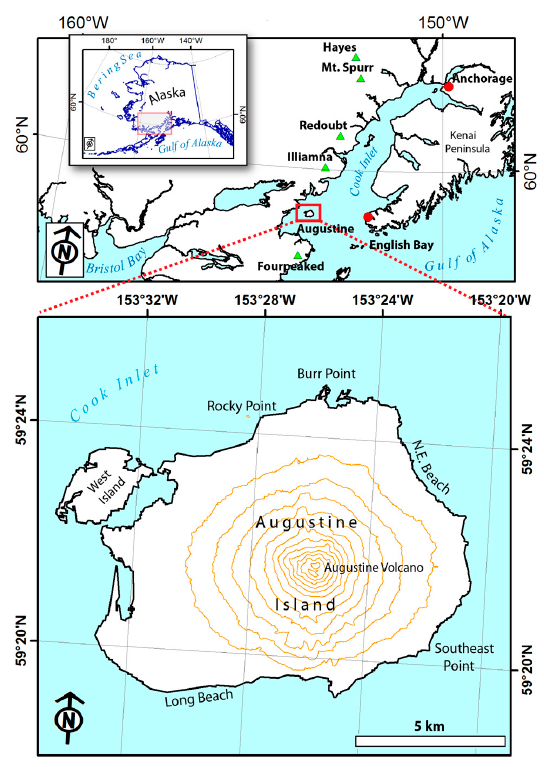
Figure 1. Augustine Island (59°21.6 ′ N, 153°25.9 ′ W) and the Cook Inlet vicinity of South-Central Alaska. Volcanos described in the text are marked by green triangles; populated places by red circles. Contour line interval is 100 m.